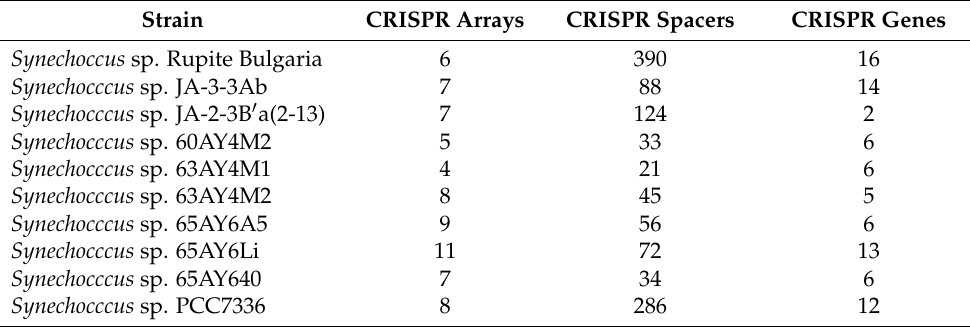
Table 1. The table summarizes basic CRISPR/Cas system features for each strain. Strain CRISPR Arrays CRISPR Spacers